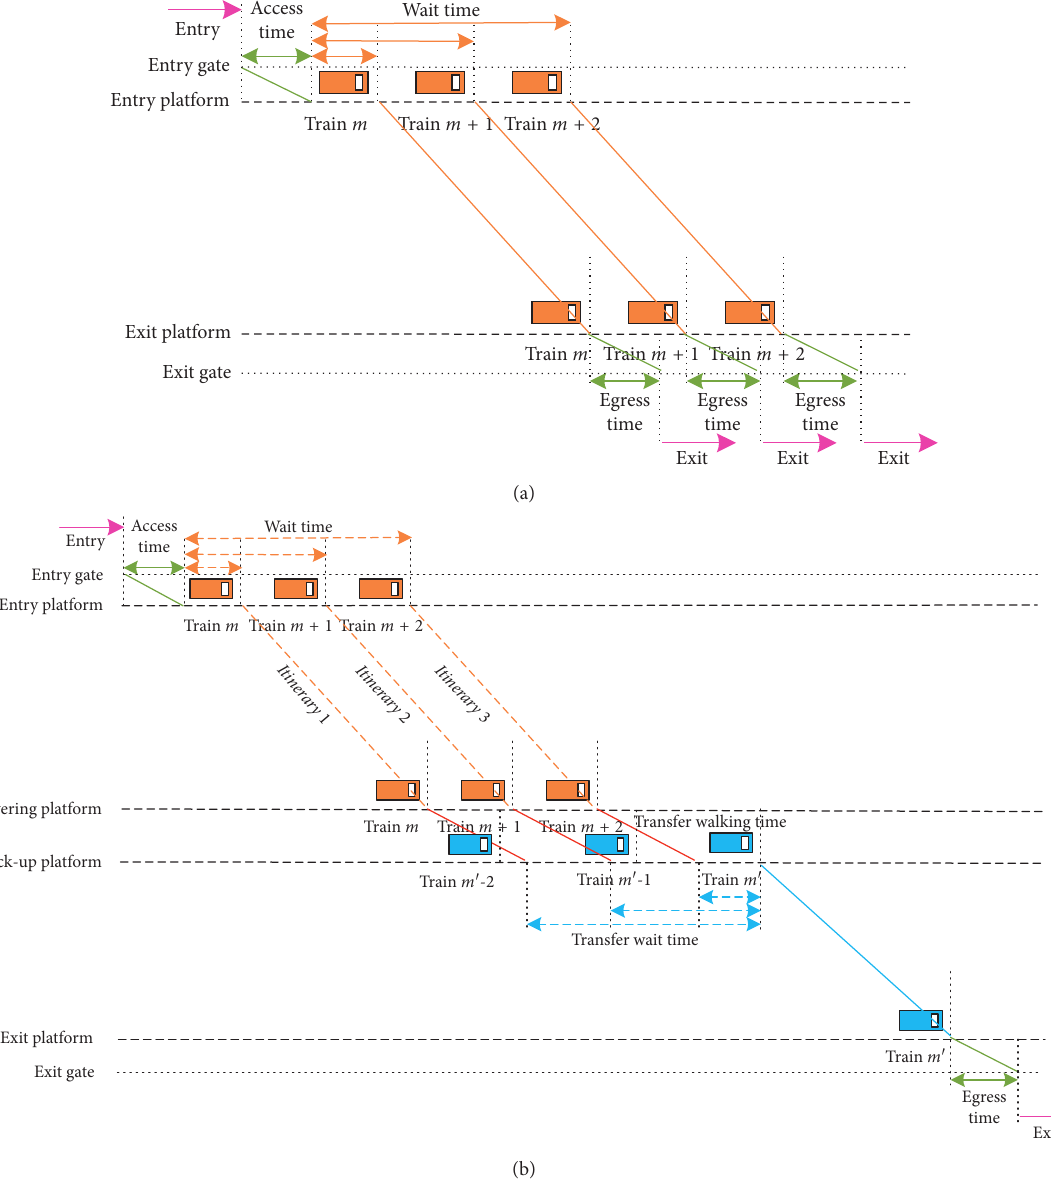
Figure 1: Space-time diagrams of passenger itineraries. (a) Passenger itineraries without transfer. (b) Passenger itineraries with one